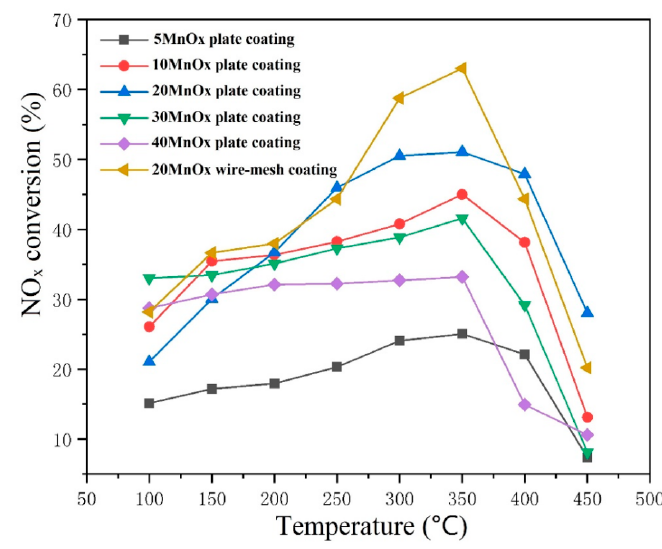
Figure 12. The activity of wire-mesh catalysts compared with stainless steel plates.